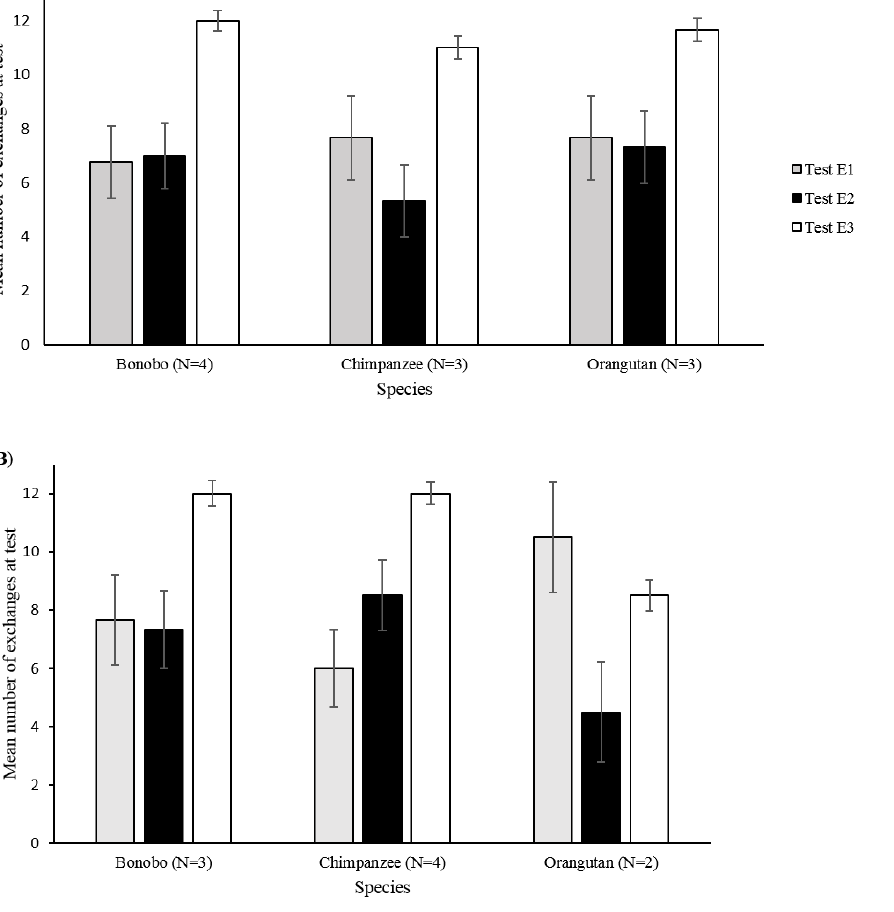
Figure 4. Mean number of exchanges needed to exchange all 4 correct objects in each test by species. A) depicts subjects in the 2 week delay period, B) depicts subjects in the 10 week delay period. Error bars denote the standard error